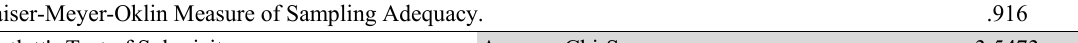
KMO and Bartlett's Test